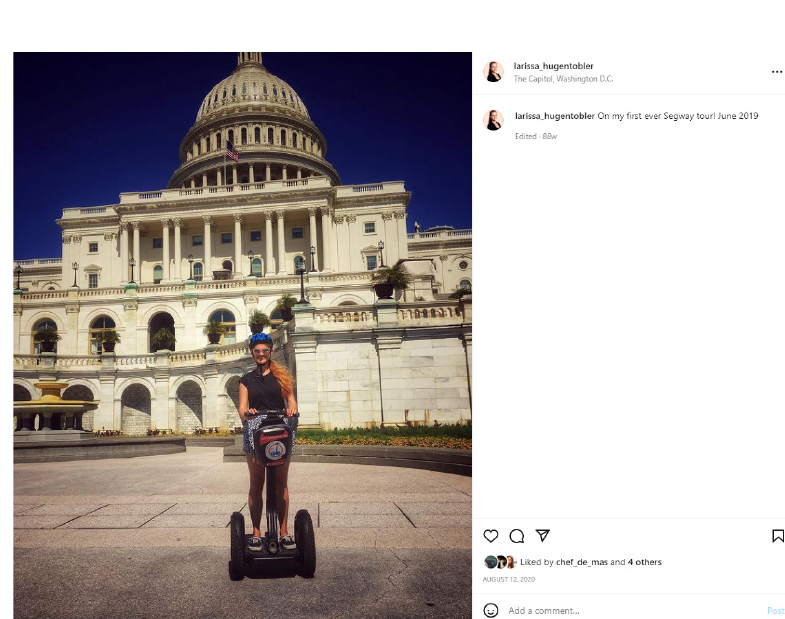
Figure 2. Instagram grid.